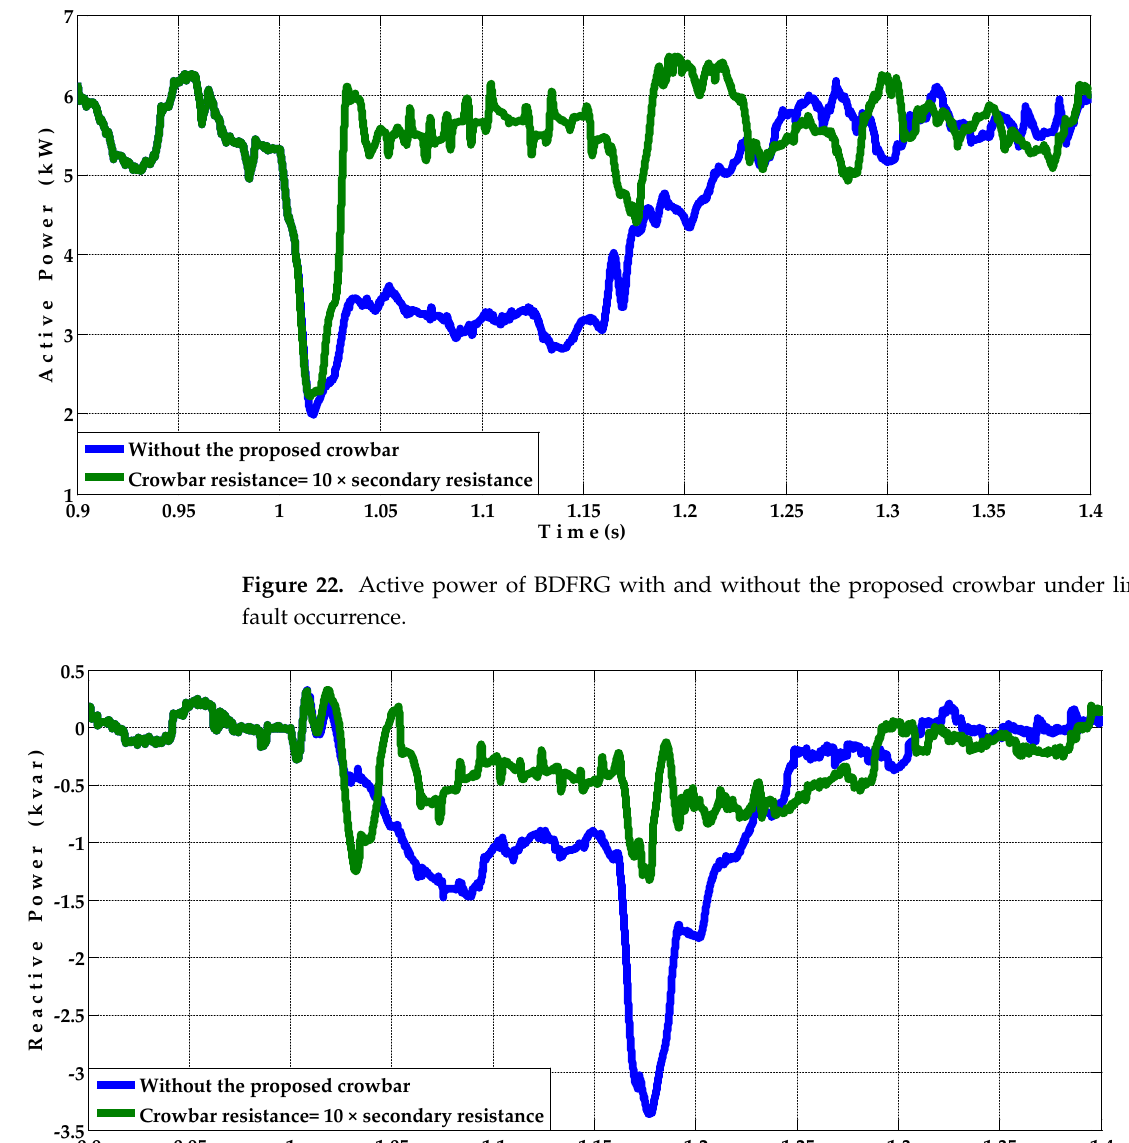
Figure 22. Active power of BDFRG with and without the proposed crowbar under line to line fault occurrence.